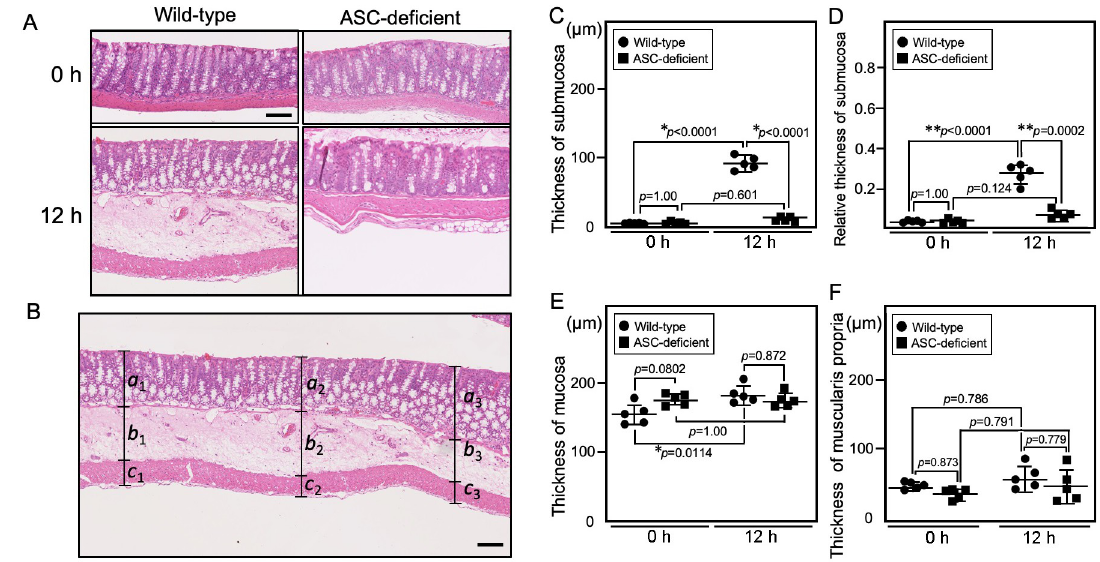
Fig 5. Histopathological comparison of the colonic submucosal edema between WT and AD mice after LPS challenge. Five mice per group were sacrificed. Each image is representative of each group. (A) HE staining of the colon before (0 h) and at 12 h after LPS challenge. Bar = 100 μ m.( B )Illustration of the method used to measure the thickness of the mucosa ( a ),submucosa ( b ),and muscularis propria ( c )of the colon. The mean thickness was the average of a + a . The mean thickness of the submucosa was taken as the average 1 + a 2 3 of b 1 + b 2 + b 3 . The mean thickness of the muscularis propria was taken as the average of c 1 + c 2 , + c 3 . Bar = 100 μ m.( C )The mean thickness of submucosa. ( D )The mean thickness of the submucosa ( b )relative to the total thickness of the mucosa/submucosa/muscularis propria ( a+b+c ).( E )The mean thickness of mucosa. ( F )The mean thickness of the muscularis propria. � p -value < 0.05. �� p -value <